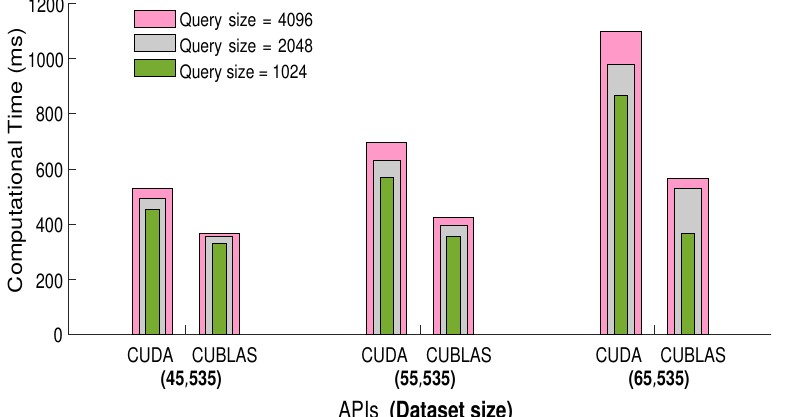
Figure 6. The comparison between CUDA and CUBLAS APIs with respect to elapsed computational time. For this experiment, K NNs are fixed to be 64, and the computational time is measured in